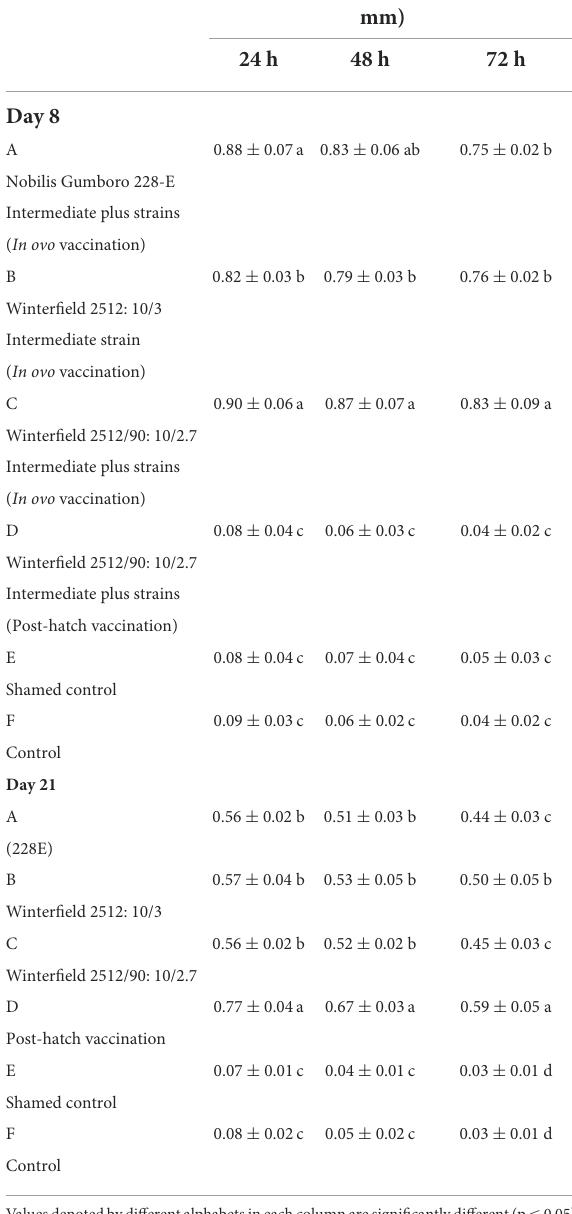
TABLE 5 ELISA log 2 titers of the White Leghorn chicks administered live IBD vaccines in ovo and post-hatch (means ± SD).